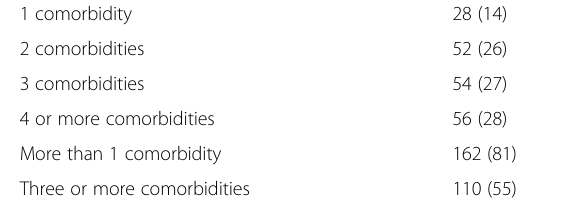
Table 1 Baseline characteristics, n = 200 patients